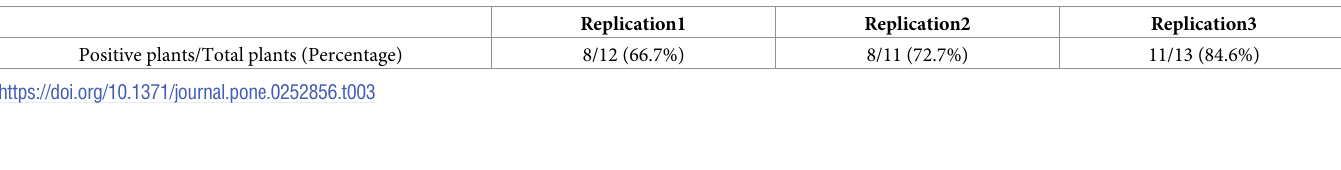
Table 3. Transmission of CGMMV to N . benthamiana by M . persicae